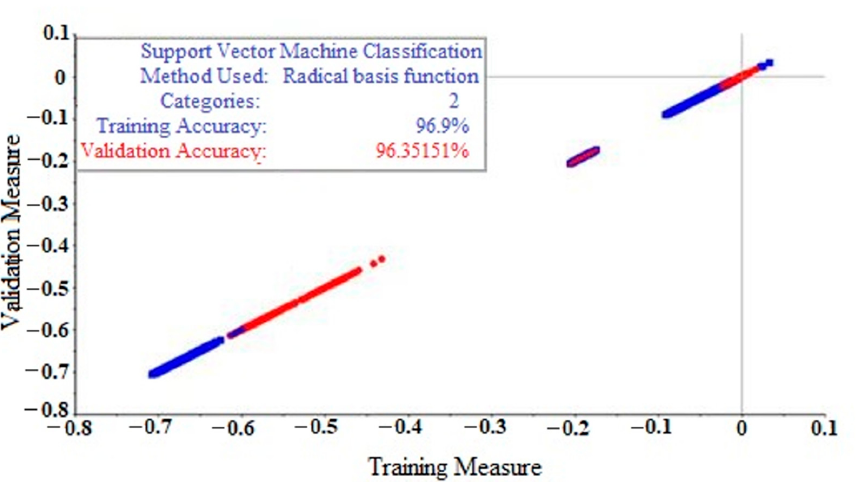
Figure 6. Accuracy of the training set of Ophiopogon japonicus with the SVM origin model, where blue is the actual value and red is the validation value.